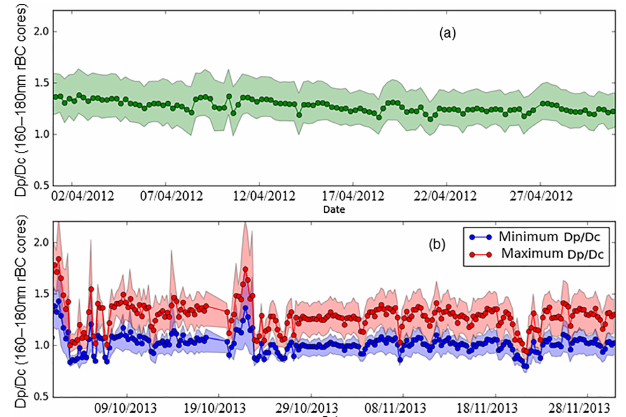
Figure 7. Time series of the mean ratio of total particle diameter (core and coating, D p ) to rBC core diameter ( D c ) for (a) April 2012 and (b) October–November 2013 with the 25th and the 75th percentile represented by the shaded region. The minimum and maximum range in the D p /D c are shown for the October– November 2013 period because the sensitivity of the scattering channel changed, resulting in two valid